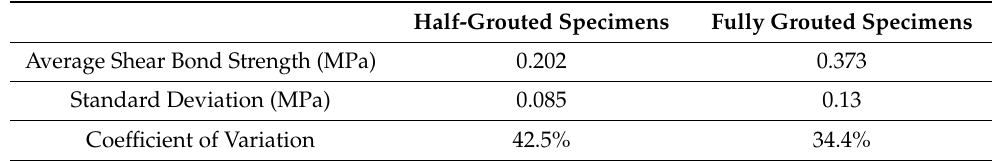
Figure 5. Shear bond strength testing of the AAC block assemblies ( a ) before and ( b ) after testing. Table 2. Shear bond strength results of the AAC assemblies.